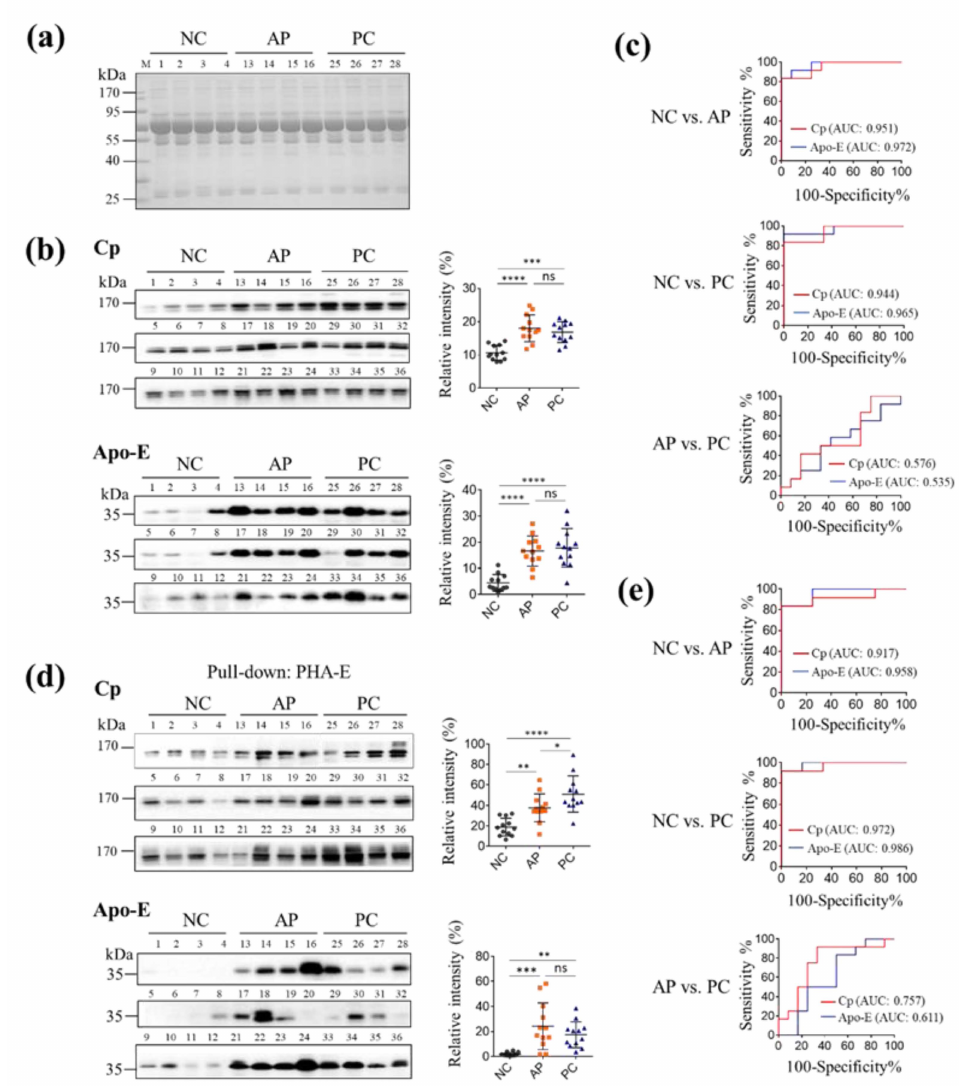
Figure 4. The expression of Cp and Apo-E and the expression of PHA-E-positive Cp and Apo-E. The protein concentrations of sera from 12 NC individuals (1–12), 12 AP (13–24), and 12 PC (25–36) patients were analyzed by CBB staining. The results of one gel were shown in ( a ), and another